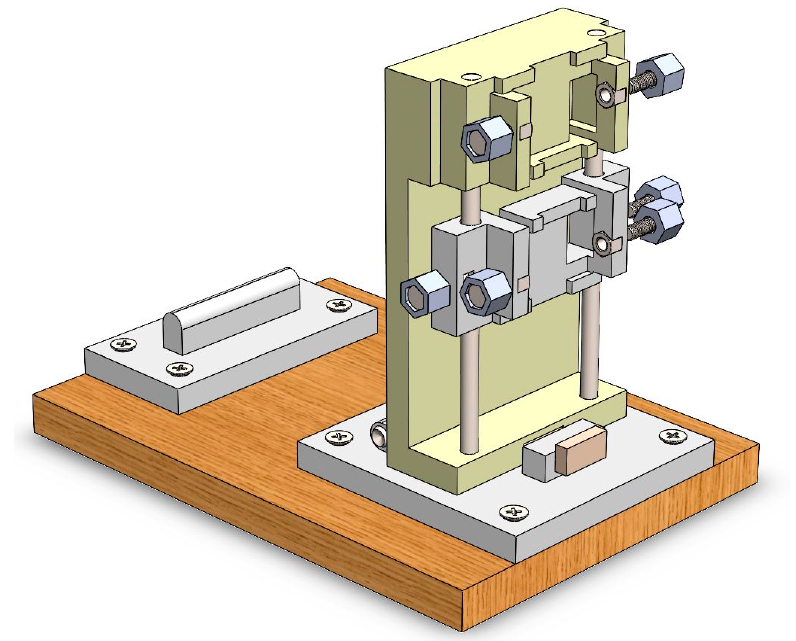
Figure 5. The vertical position of the calibration device.